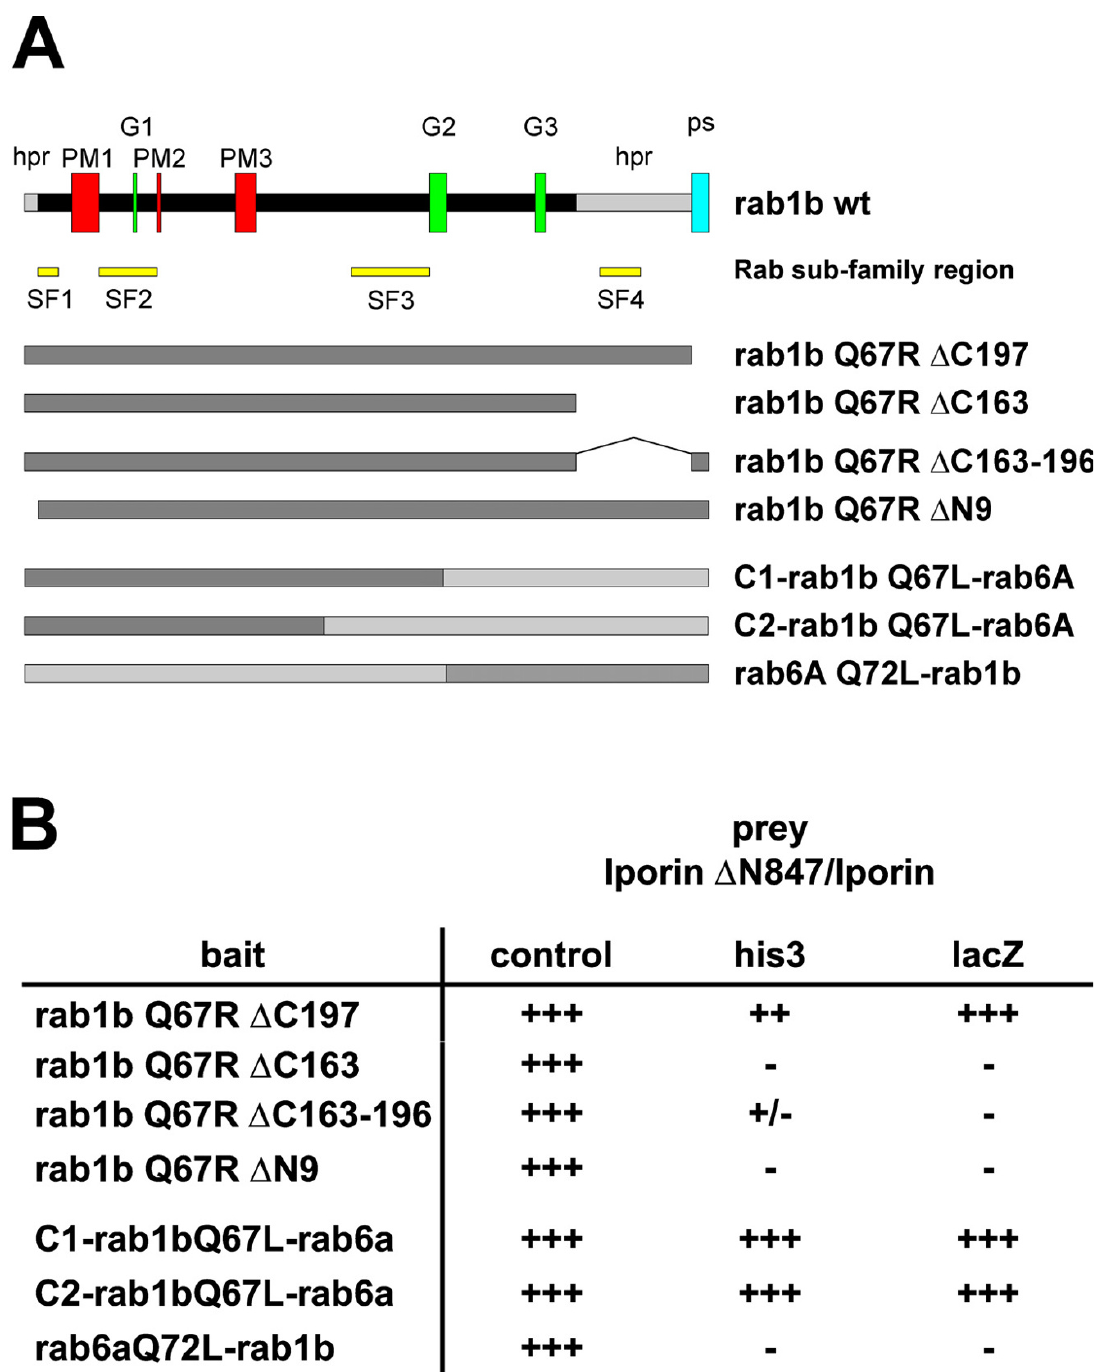
Figure 1 Determination of the Iporin interacting domain. (A) Schematic overview of the domain structure of rab1b with the conserved G1-G3 boxes, PM1-3 motifs, N-terminal and C-terminal hypervariable regions (hpr) and the C-terminal prenylation site (ps). SF1-4 indicate the rab subfamily regions. The rab1b regions of the chimeras are shaded dark and the rab6 regions are light-shaded. (B) All constructs were co-transformed in yeast and cells were cultivated on selection plates as described above (Table 1). Rab1b deletion mutants were co-transformed with Iporin ∆ N847, whereas chimeras were co-transformed with full- length Iporin. - = no growth on selection plates or no β -galactosidase activity; +/- = background growth or β -galactosidase activity appears overnight; ++ = strong growth; +++ = very fast growth or high β -galactosidase